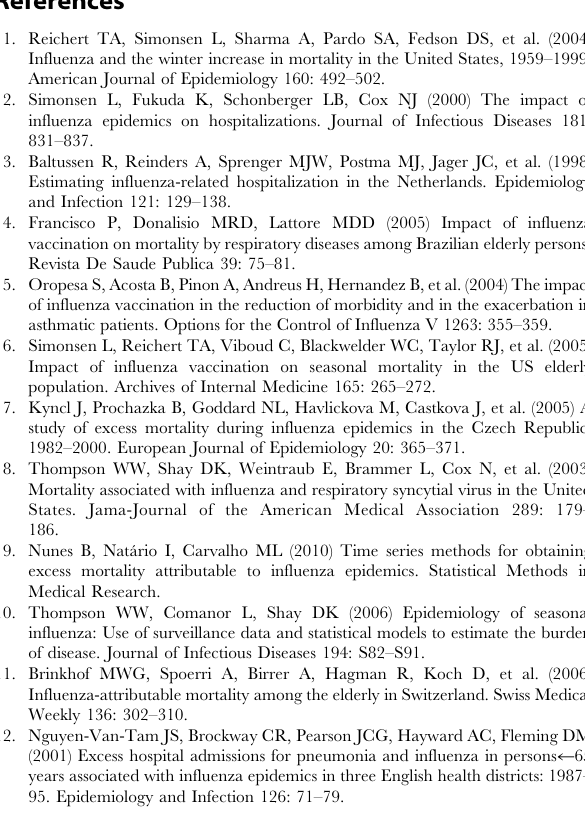
Table S3 Seasonal ARIMA best-fitted models by R package forecast and Box-Ljong test for residuals auto correlation. Table S4 Correlation matrix between seasonal age- standardized excess rates. Injuries are used as a control time series which should not be associated with influenza virus circulation. Table S5 Sensitivity analysis: excess deaths and age- standardized excess death rates from injuries that are ‘‘attributable to influenza’’ by our method. Injuries comprise all external causes of